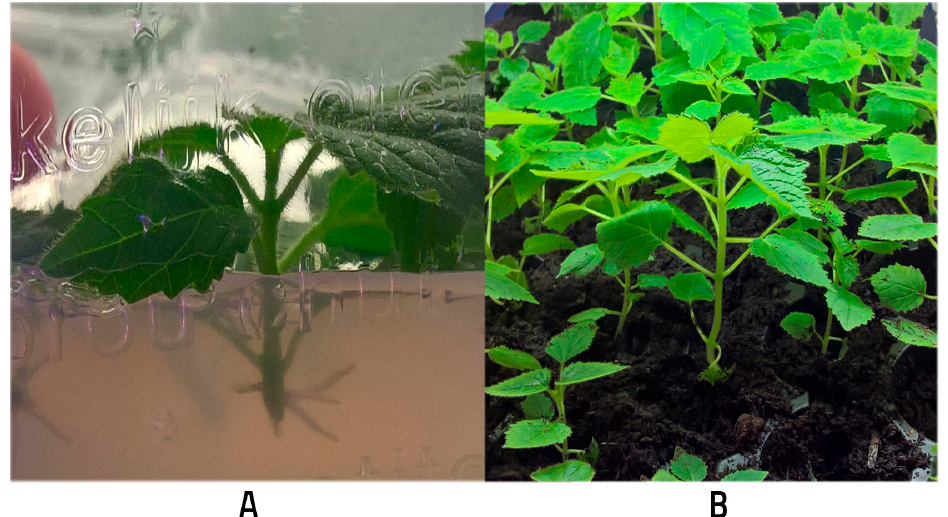
Figure 1. P. tomentosa × P. fortunei rooting and acclimatization. ( A ). P. tomentosa × P. fortunei rooting using MS4 medium after 2 weeks. ( B ). P. tomentosa × P. fortunei acclimatized plants after 3 weeks.